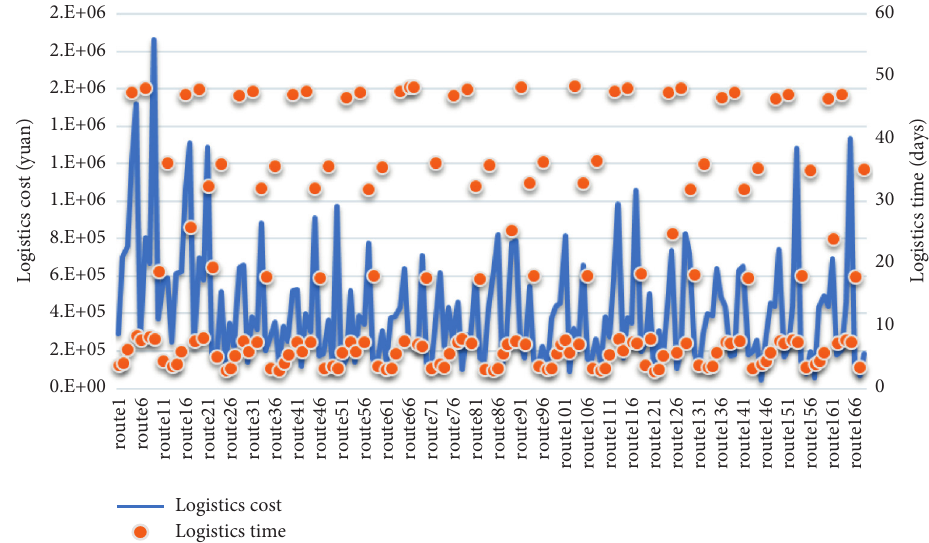
Figure 11: The result of optimal cross-border logistics paths excluding cross-border air transportation.